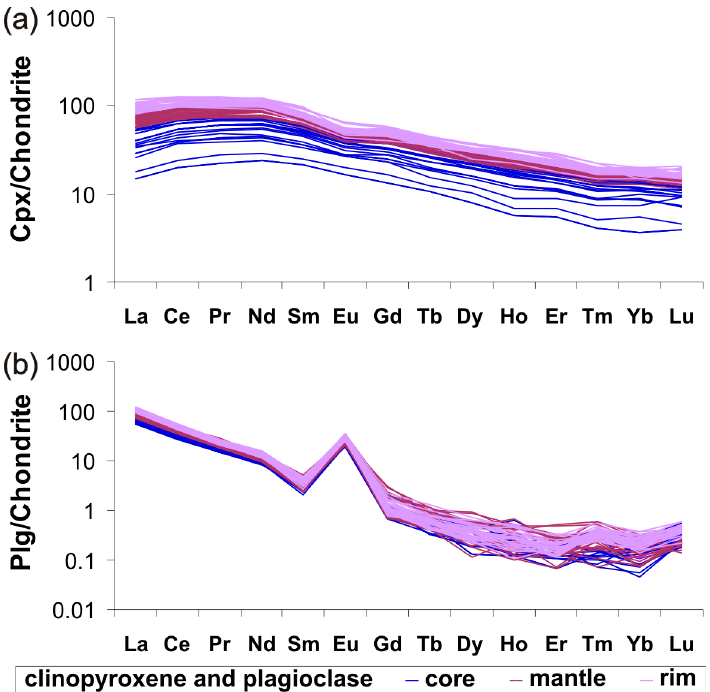
Figure 4. Chondrite-normalized patterns [44] of REE showing the trace element concentrations analyzed in clinopyroxene ( a ) and plagioclase ( b ).